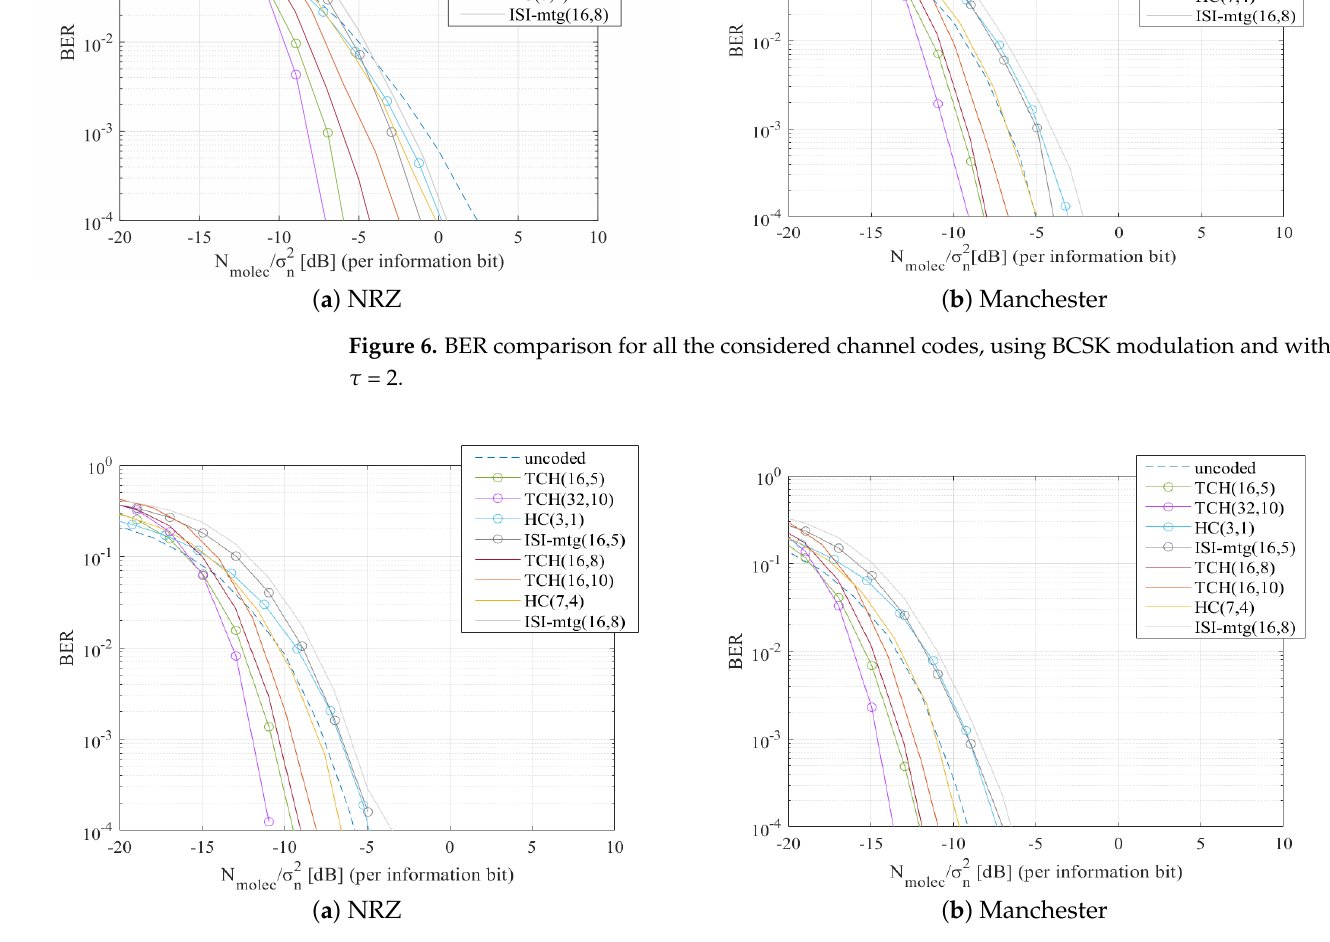
Figure 7. BER comparison for all the considered channel codes, using BCSK modulation and with τ =